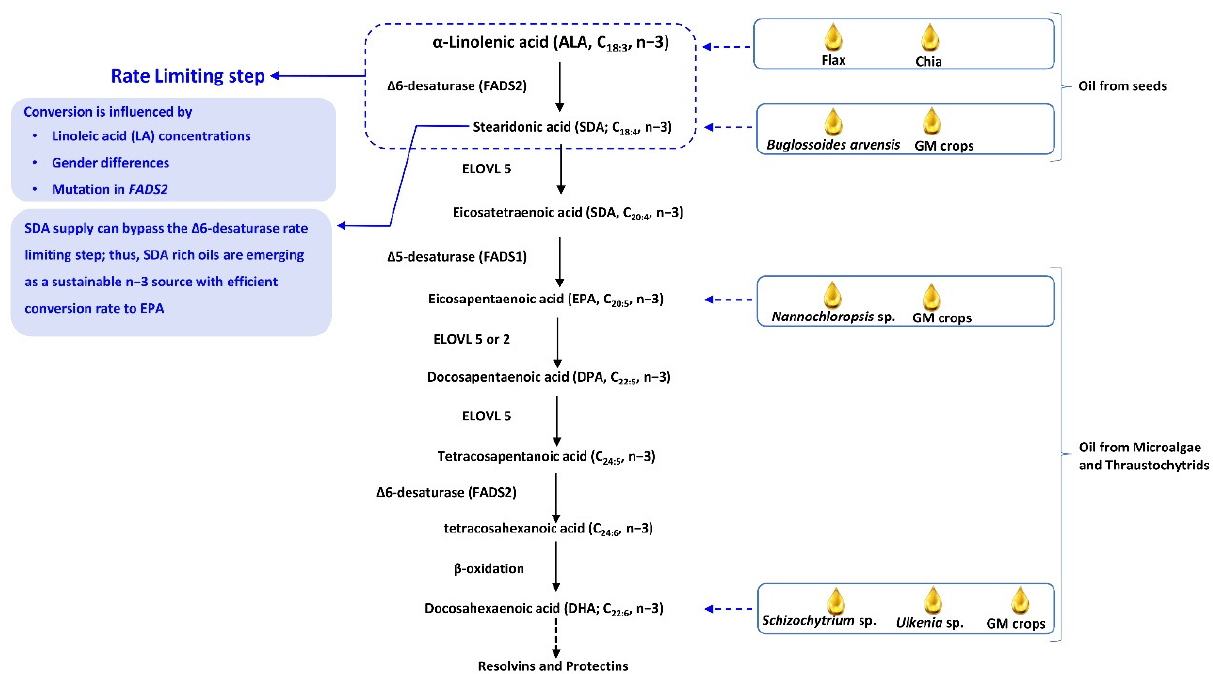
Figure 1. Illustrations showing that dietary supplementation of SDA (instead of ALA) can bypass the first rate-limiting step; so food rich in SDA is more beneficial than is ALA for increasing the EPA levels in the body.